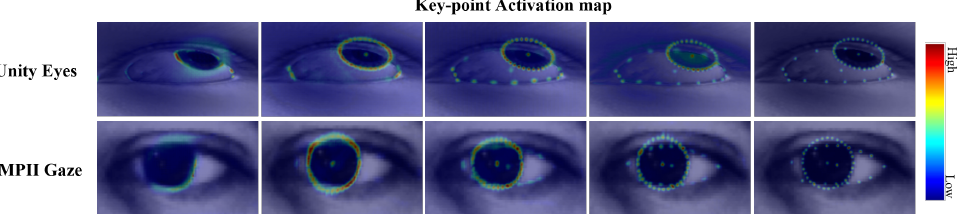
Figure 1. From left to right, the predicted heatmaps are shown as the training epoch increases. The heatmaps have high confidence scores where the landmarks are most likely to be located, and the right bar represents the color space corresponding to the confidence